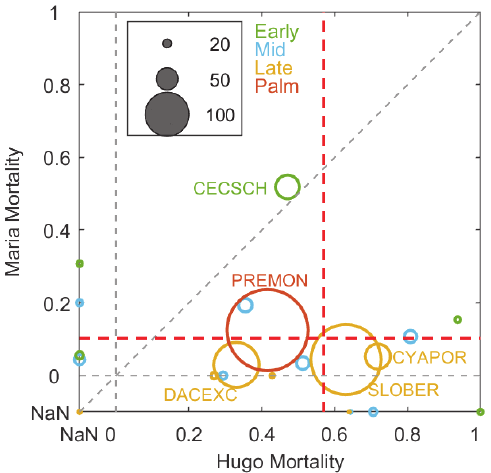
Figure 2. Mortality of each species during Hugo and María. Red lines are community-average mortality, one circle represents one species and the species codes of the five most abundant species are shown. “NaN” indicates that the mortality was not calculated because the sample size was small (<10). The size of the circles is proportional to stem count and the color indicates PFT.